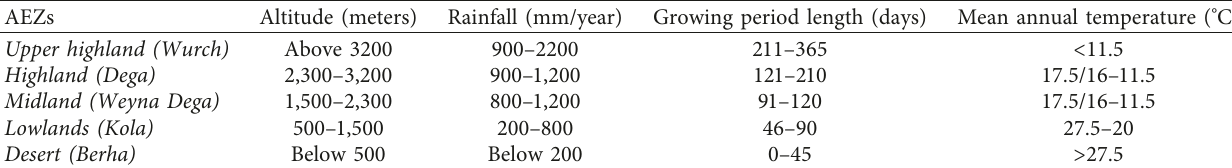
Adapted from MoA